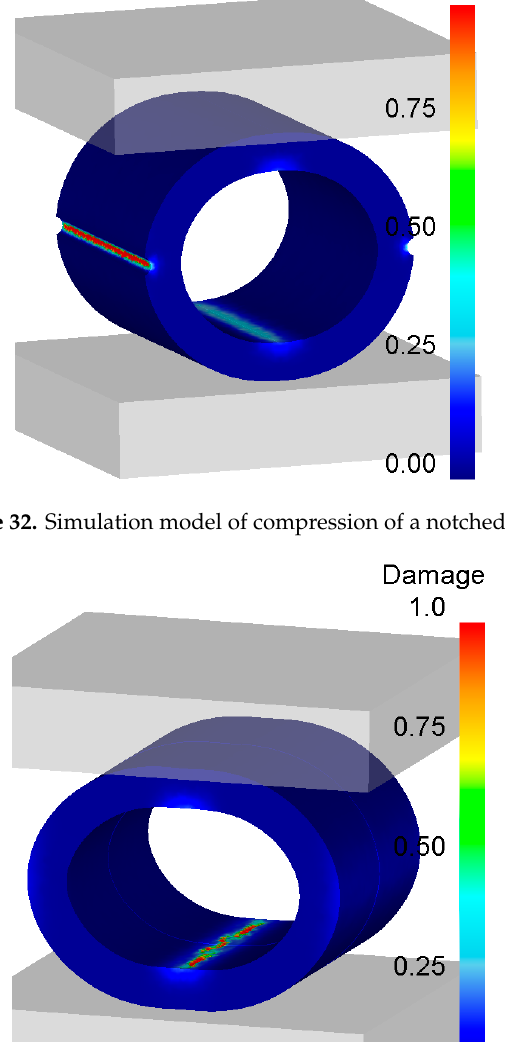
Figure 34. Measured forces in radial compression of rings and the forces simulated with the use of the NCL fracture criterion.